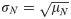
Relationship between mean and standard deviation of customer-numbers time series by category: cheese (red) and hair-styling (blue).Solid, dashed and dotted line show σN=μN, σN = 0.19μN, and σN = 0.06μN respectively.